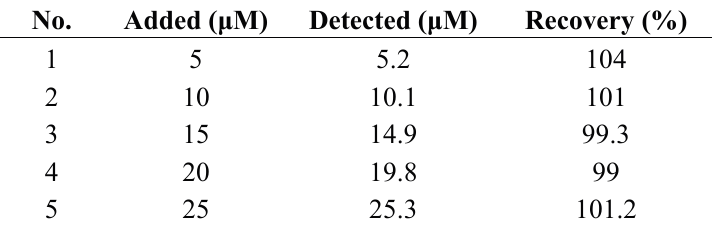
Table 2. Results of recovery tests for the detection of DA in human urine